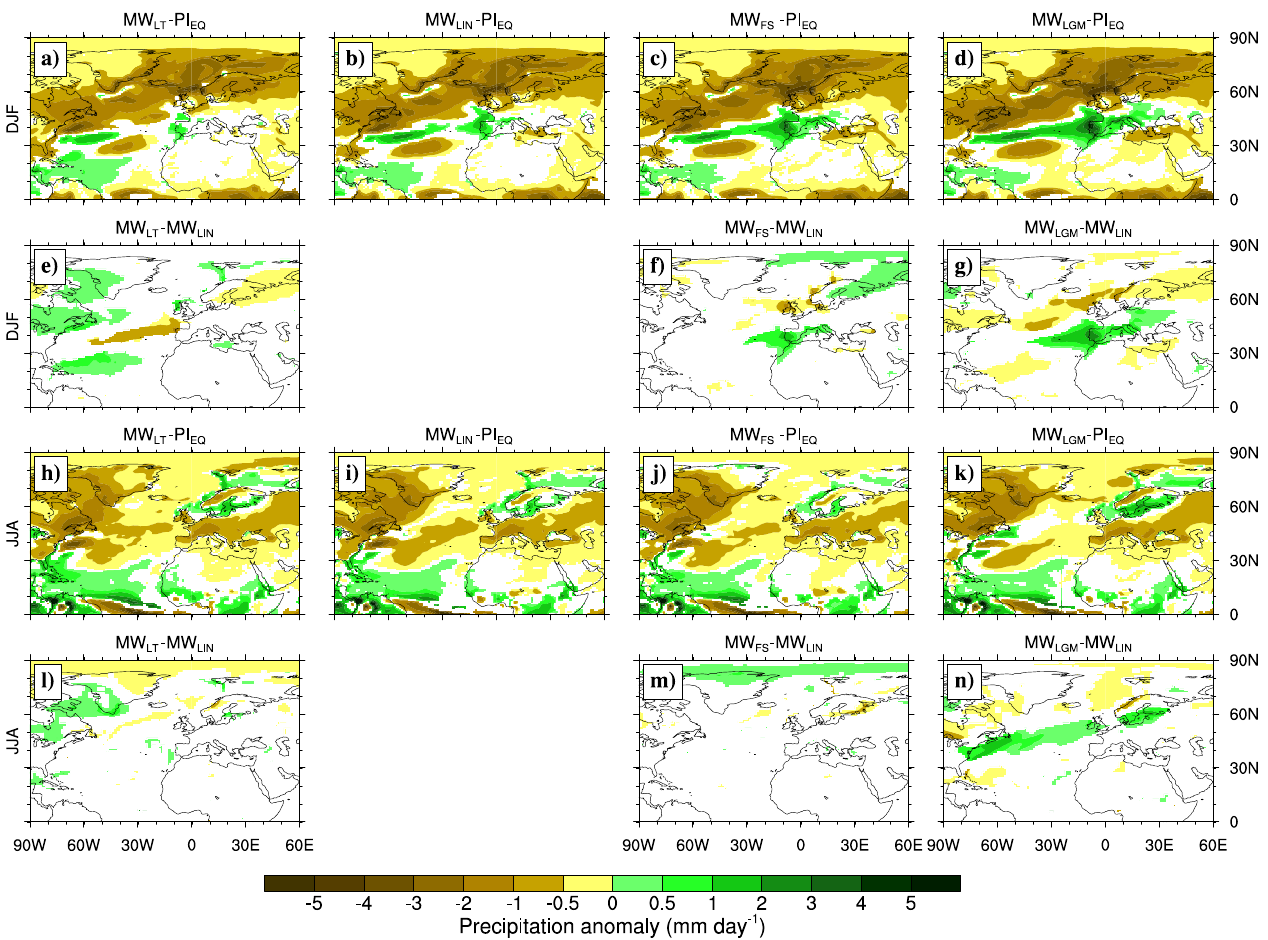
Fig. 4. Winter (DJF, upper half) and summer (JJA, lower half) precipitation anomalies with respect to PI EQ ( a – d and h – k ) and to MW LIN ( e – g and l – n ) for all MW simulations. Only values that are statistically significant at the 5% level based on the two-sided Student’s t-test are